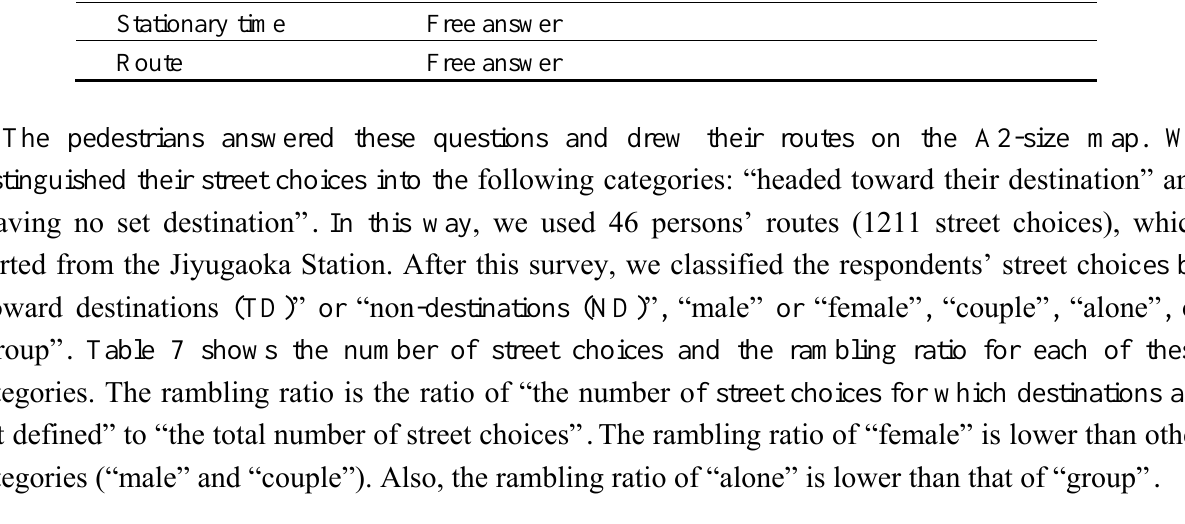
Table 7. Number of choices and rambling ratio for each